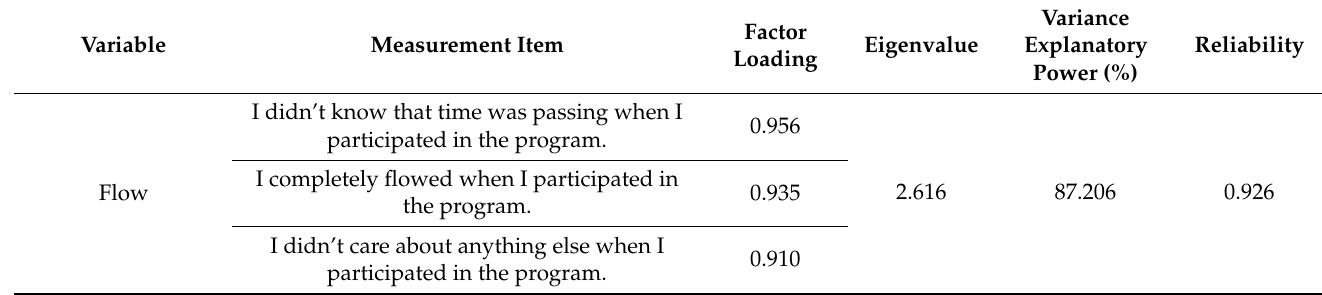
Table 10. Results of factor analysis of wellness tourism product flow measurement